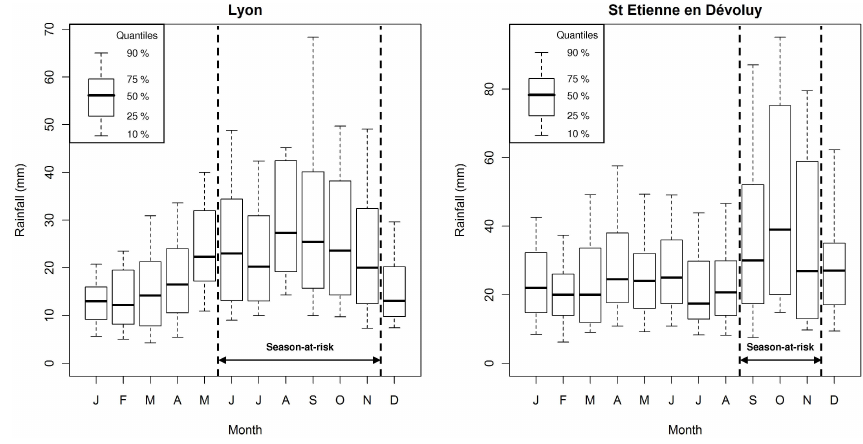
Fig. 4. Box plot of the annual maxima for each month at Lyon rain gauge (left) and St Etienne en D´evoluy (right) (records for the period 1953–2005). Dashed lines and double arrow highlight the “season-at-risk” (season of occurrence of highest rainfall quantiles) at Lyon (June to November) and St Etienne en D´evoluy (September to November).